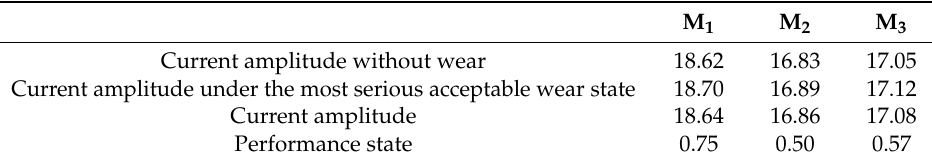
Table 2. Performance state of the manufacturing